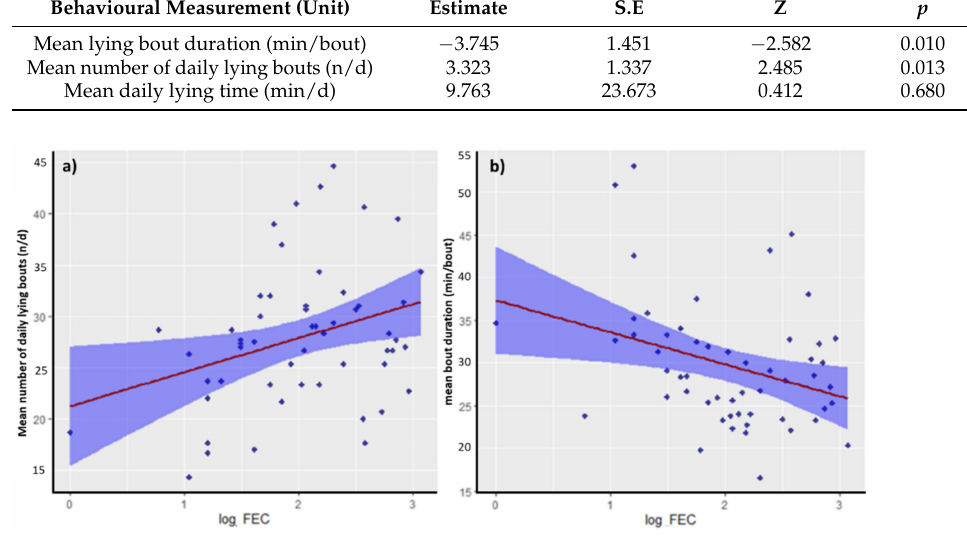
Figure 1. Visualisation of significant ( p < 0.05) association detected by linear mixed models between log FEC and ( a ) mean number of daily lying bouts (n/d) and ( b ) mean bout duration (min/bout). Shaded areas signify 95% confidence intervals of the regression equation. Residual degrees of freedom = 50 for each model. Table 3. Multivariate linear mixed models of factors associated with periparturient ewe